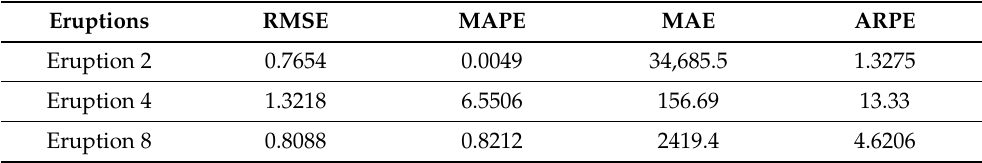
Table 6. Results from system of gamma(a,b) OU model. The results reported are the best results from modeling a combination of eruptions 2, eruptions 4 and eruptions